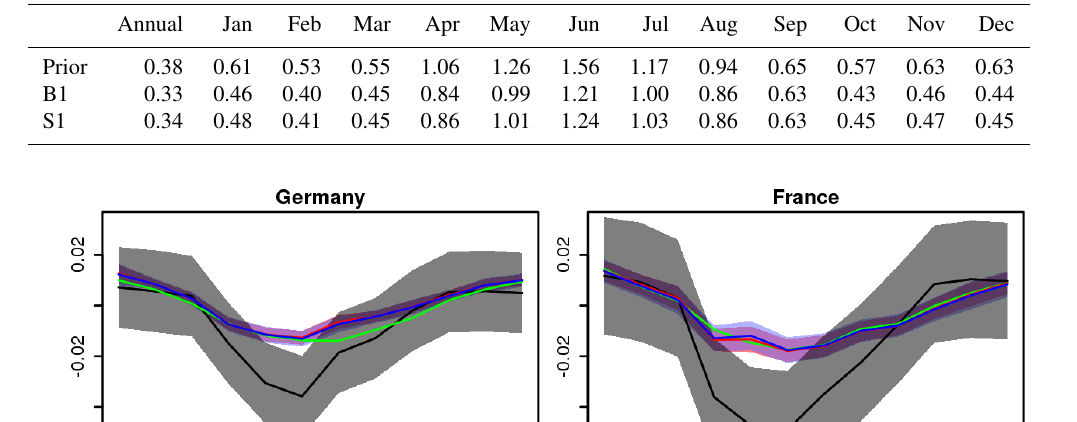
Table 4. Performance of the two error structures expressed as the spatial RMSD of the optimized monthly and annual NEE fluxes compared to the truth for the whole domain in µmolem − 2 s − 1 .